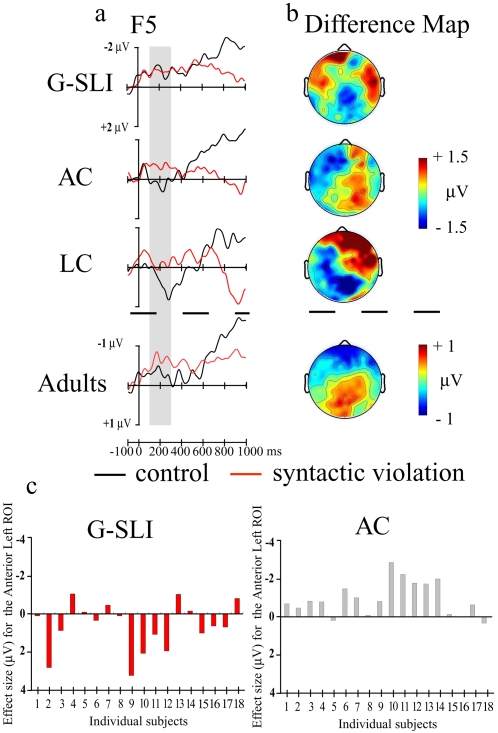
Syntactic dependency component (ELAN, 100–300 ms -grey area) elicited for the syntactic violation.
a. ERP waveforms for the groups from F5 (left frontal) electrode. b. Scalp distribution of differences between the violation minus control sentences for each group. The syntactic violation elicited a negativity distributed on the left hemisphere for the age controls (Condition×Hemisphere: F
1,17 = 10.16, p<.005), and the language controls (Condition×Hemisphere: F
1,19 = 11.12, p<.003; Condition×Caudality×Hemisphere: F
2,38 = 3.55, p<.05), with a maximum of difference on the anterior left sites for both groups (p<.006, p<.05 respectively). This negativity is equally distributed on anterior sites for the adults (Condition×Caudality: F
2,38 = 10.17, p<.001; anterior central p<.001). No effect was significant for the G-SLI children (F<1). c. Effect sizes for individual G-SLI children and their age controls (numbers correspond to matched individuals with increasing numbers corresponding to increasing age). Effect size: mean amplitude difference (violation minus control) in the Anterior Left ROI in the 100–300 ms time window. We plot Negativity upward.